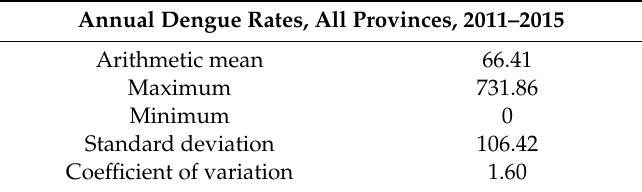
Table 1. Summary statistics, dengue rates (counts per 100,000 population by province-year), 2011–2015.